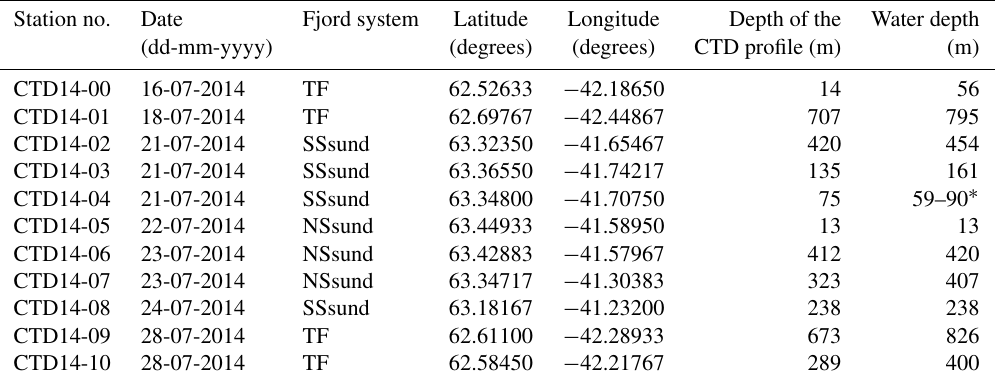
Table 3. Overview of the 11 CTD profiles. Station